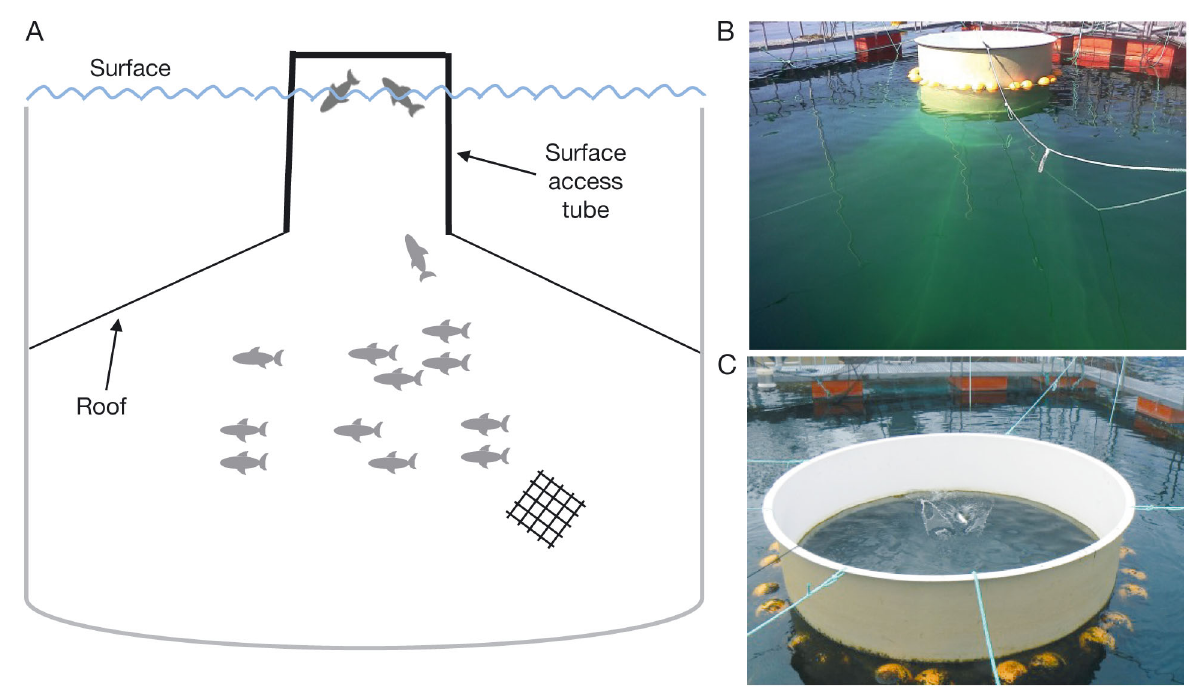
Fig. A1. (A) Schematic diagram of the central lice barrier installed in a standard surface-based Atlantic salmon sea-cage. Salmon can access the surface only within the area enclosed by the surface access tube (‘snorkel’). (B) View of the lice barrier tube in position with roof netting visible below the surface. (C) A salmon rolling at the surface to refill air in the swim bladder within the surface access tube